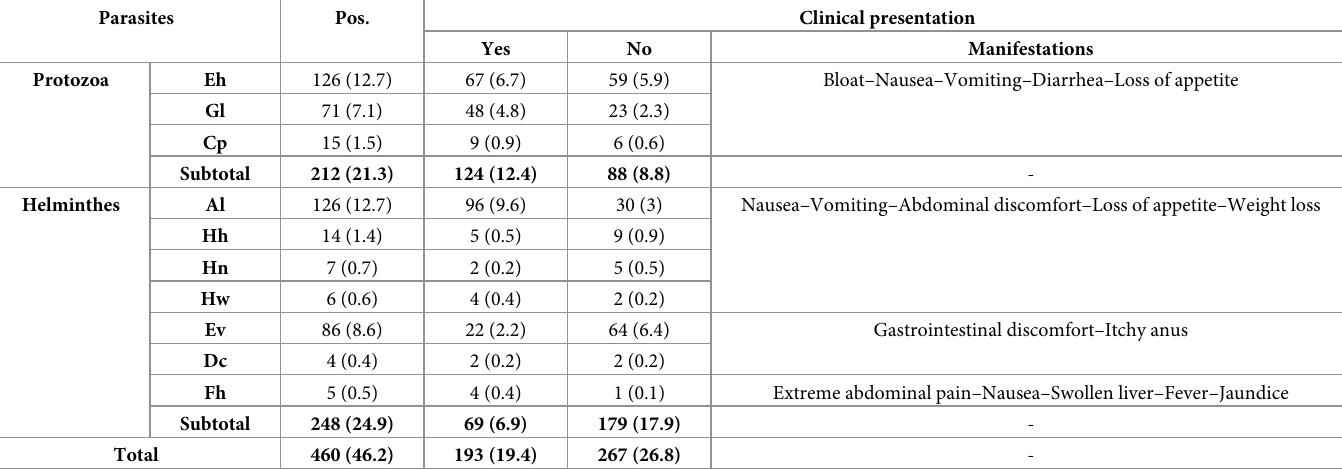
Table 1. Prevalence of IPIs and their associated clinical manifestations in children in Gharbia governorate, Egypt. Parasites Pos. Clinical presentation